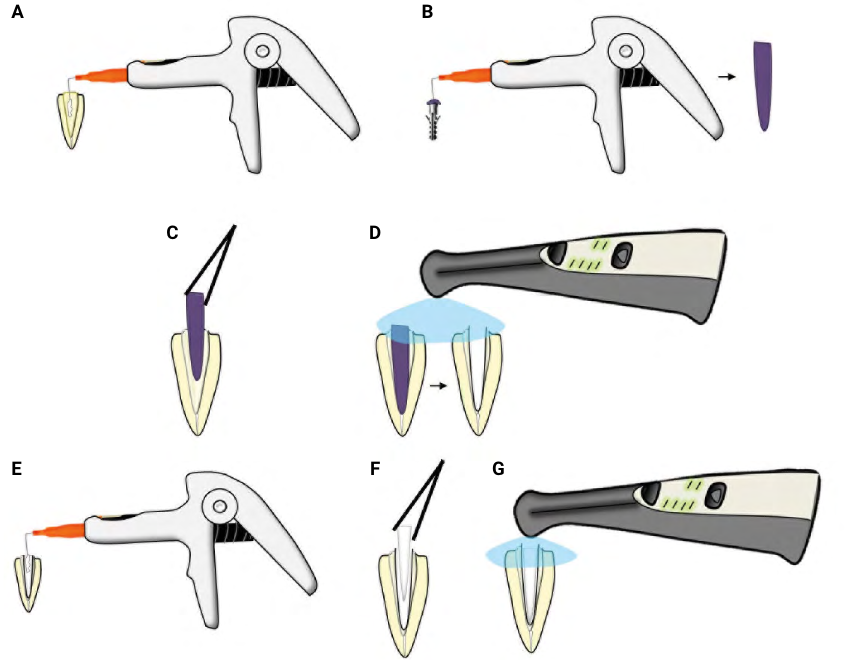
Figure 1. Illustrative scheme of the two-step technique for glass fiber post